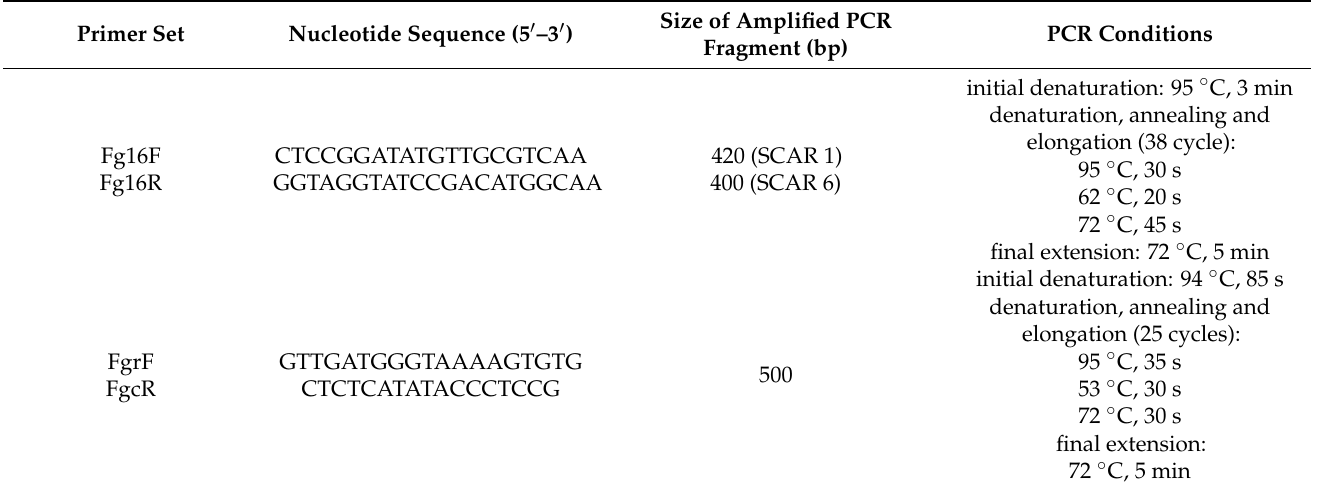
Table 1. Primer sets and PCR conditions for screening of the